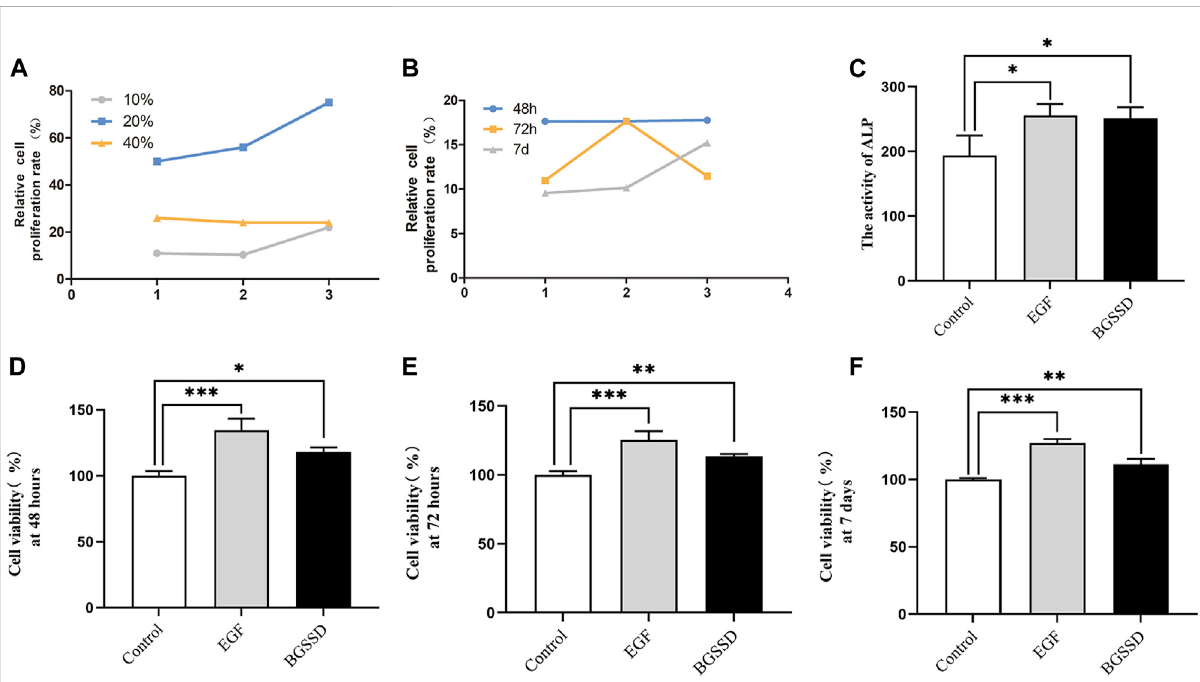
FIGURE 3 BGSSDincreasedosteoblastproliferation.Control:MC3T3-E1+20%concentrationofblankserum;EGF:MC3T3-E1+EGF;BGSSD: MC3T3-E1 +20%drug-containingserumofBGSSD. (A) Theeffectsofdifferentconcentrationsofdrug-containing serum ofBGSSDonMC3T3-E1 proliferation. (B) Effect of 20% drug-containing serum of BGSSD on MC3T3-E1 cells proliferation at 48, 72 h and 7 days. (C) The activity of ALP was determined by ELISA. (D – F) The effect of EGF or 20% drug-containing serum of BGSSD on cell viability at 48, 72 h, and 7 days. The data in the A and B were expressedbyalinechart;otherdatawereexpressedasmean±SD. (C – F) ,* p < 0.05,** p < 0.01,*** p < 0.001,versusthecontrolgroup;allassayswere repeated more than three